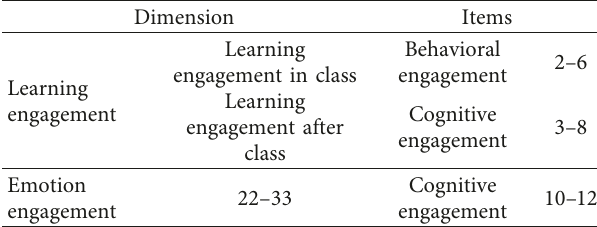
Table 4: Analysis results of paired samples.